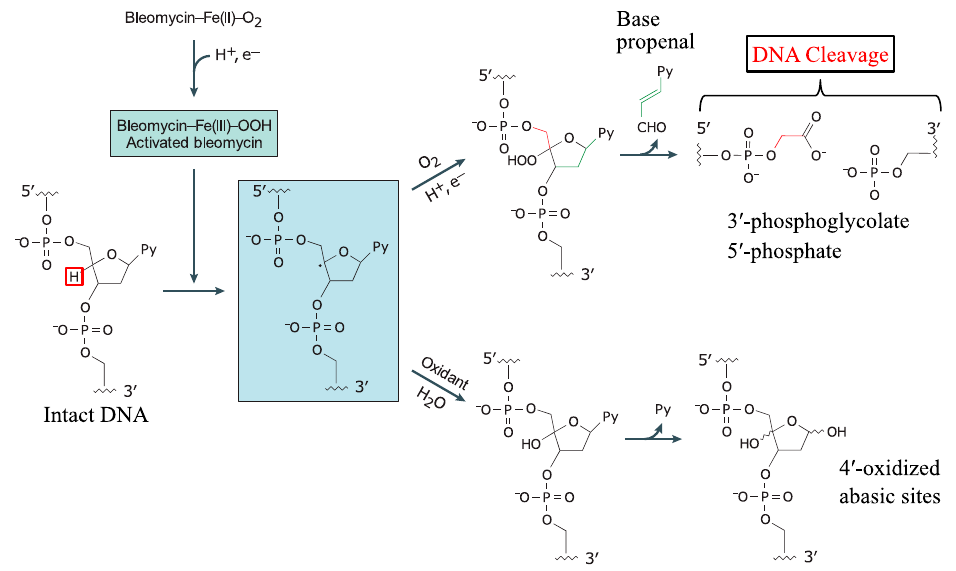
Figure 2. Mechanism of bleomycin-mediated DNA cleavage. The Bleomycin-Fe(III)-OOH activated form is generated in the presence of a one-electron reductant, Fe 2+ and oxygen. The activated bleomycin then abstracts the hydrogen atom (red square) from C4 ′ of the deoxyribose moiety of DNA to form the intermediate 4 ′ radical. This intermediate can partition into two pathways. In the abundance of oxygen, the 4 ′ radical initiates a series of chemical transformations, leading to a direct strand break and producing 3 ′ -phosphoglycolate and 5 ′ -phosphate ends, and release of a base propenal. However, in the absence of oxygen, the intermediate reacts with an oxidant in the presence of water, generating 4 ′ -oxidized abasic sites. The figure is adapted from [15] and reprinted by permission from Springer Nature.